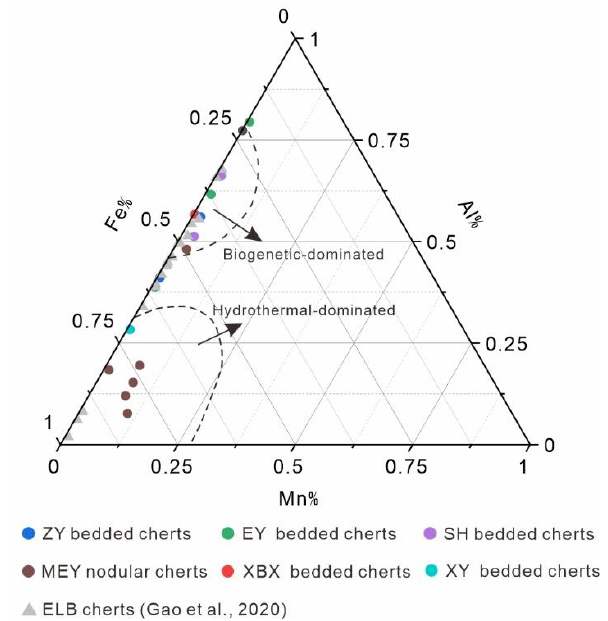
Figure 6. The ternary diagram of Al–Fe–Mn of the Maokou cherts in the Sichuan Basin. The hydro- thermal- and biogenetic-dominated distribution zones are according to Adachi et al.